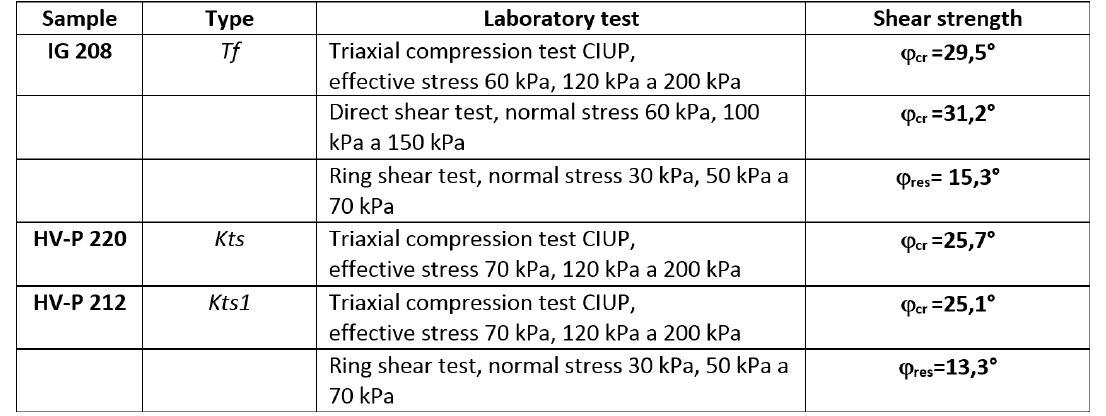
Table 2. Results of shear strength